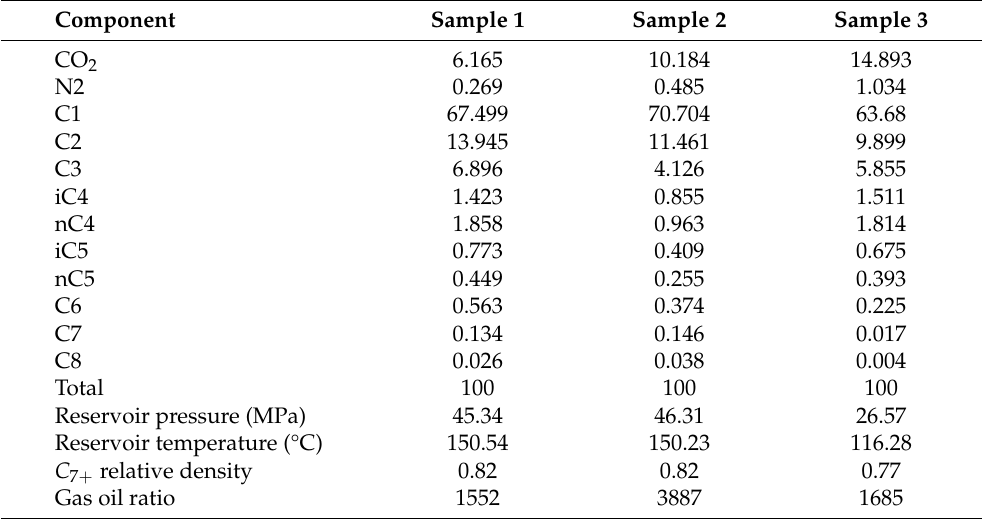
Table A1. Compositions of three condensate gas mixtures from three different wells in the H2 field, where the unit is the mole fraction (percentage).